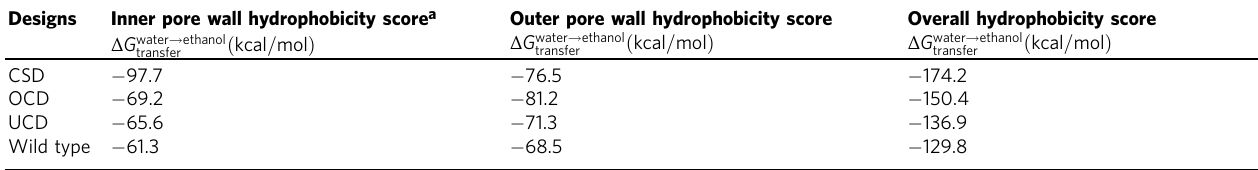
Table 1 Ranges of values for the inner pore wall, outer pore wall, and overall hydrophobicity scores